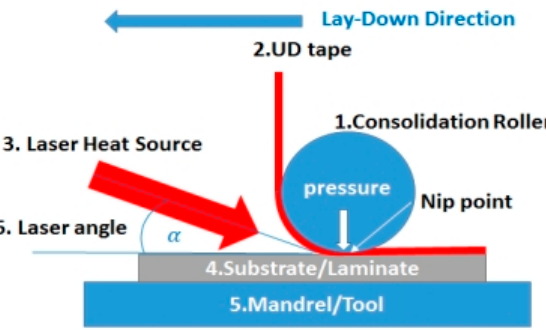
Figure 1. A laser-assisted tape placement head (LATP).